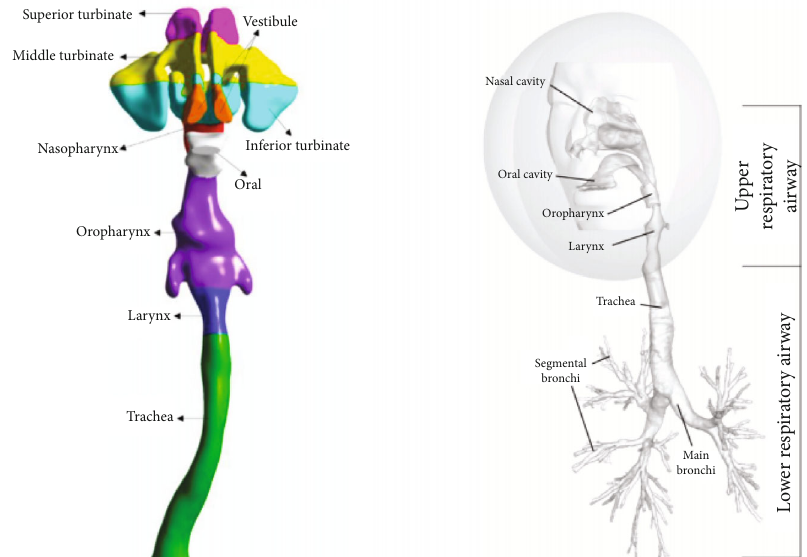
Figure 4: Graphs of structure of human beings ’ respiratory